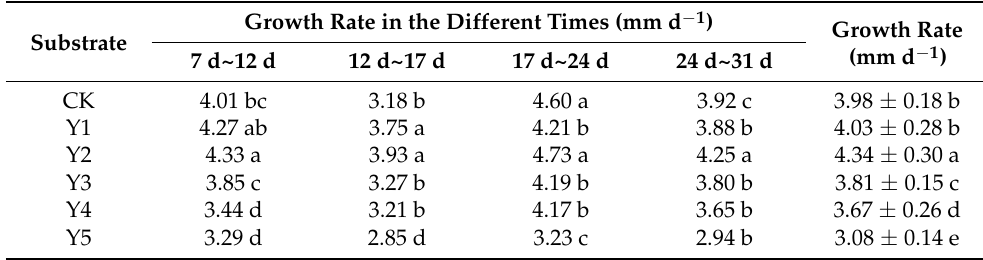
Table 3. Physical characteristics of Pleurotus eryngii when cultivated on different substrates # (mean ± SD, n = 5).